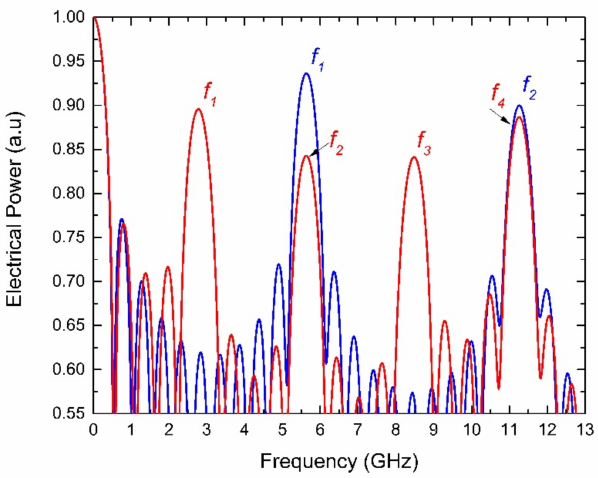
Figure 7. Simulated frequency response of the MPF corresponding to δλ = 0.82 nm (blue curve), and δλ = 1.61 nm (red